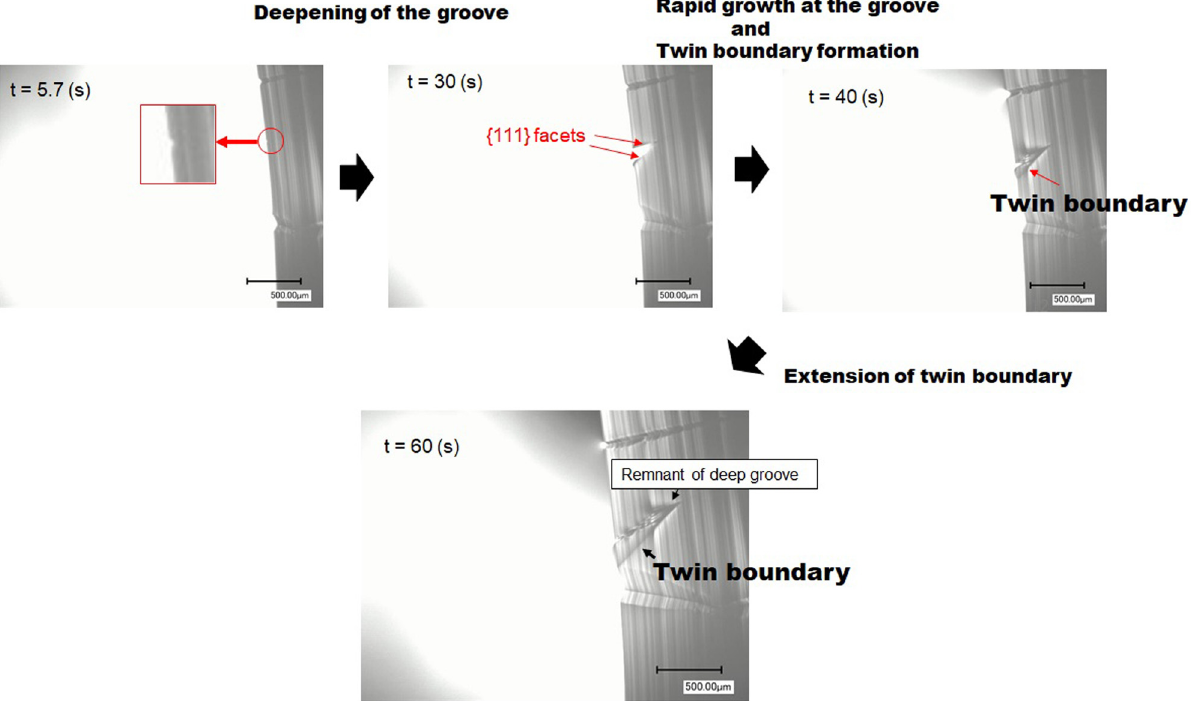
Figure 12: Process of twin boundary formation at a grain boundary groove. When the groove becomes deep enough, rapid growth occurs at the groove, and then twin nucleation occurs on the { 111 } facet that formed the groove [ 102 ]